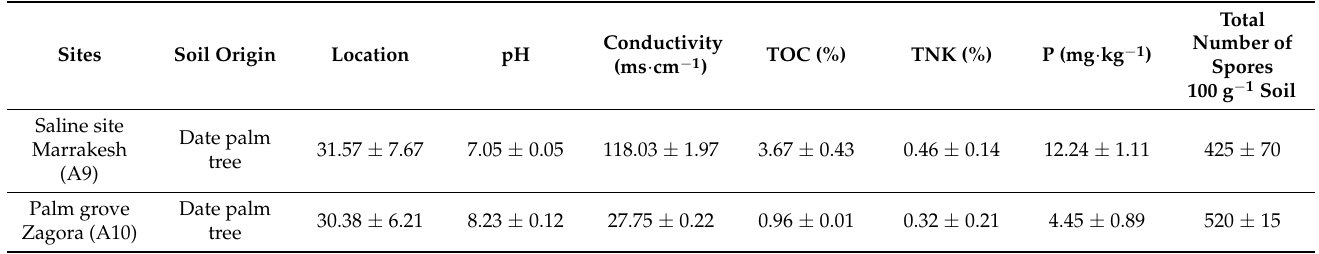
Table 1. Geographical, physicochemical, and fungal spore richness of sampled rhizosphere soils of the date palm tree.